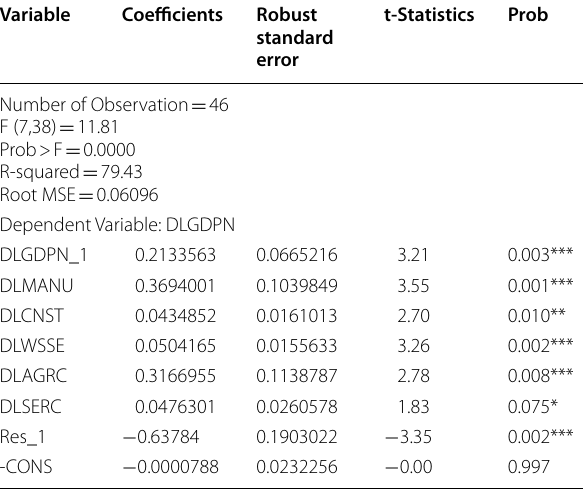
Table 11 Parsimonious model after correction of heteroscedasticity